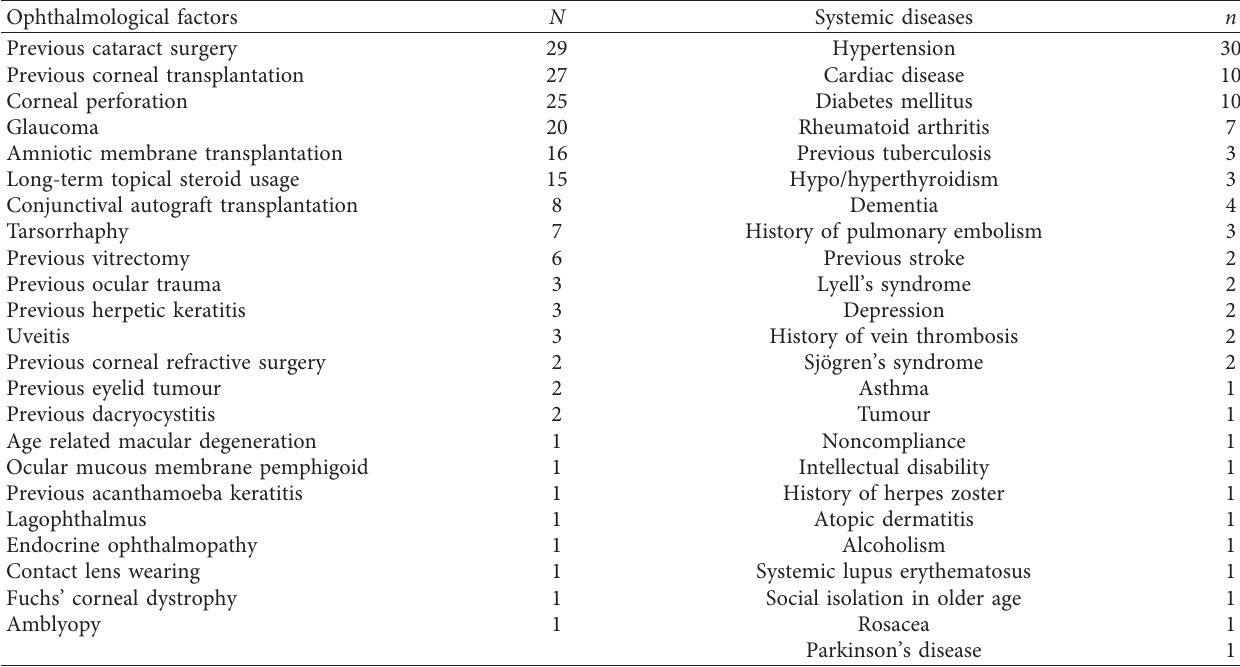
Table 3: Associated preexisting ophthalmological factors and systemic diseases for patients who underwent enucleation or evisceration due to infectious keratitis between January 2007 and December 2018 at the Department of Ophthalmology of Semmelweis University (Budapest, Hungary) (48 eyes of 47 patients).